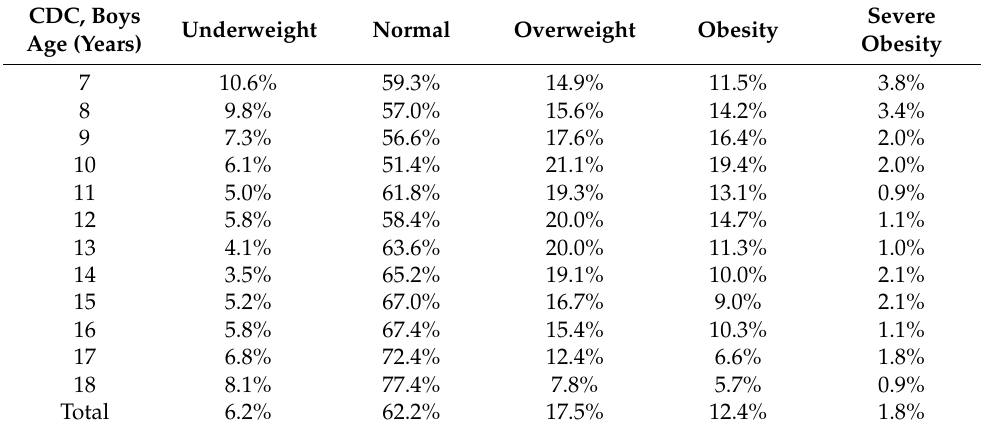
Table 6. Underweight, overweight and obesity prevalence in boys, according to the age, using CDC percentile reference.